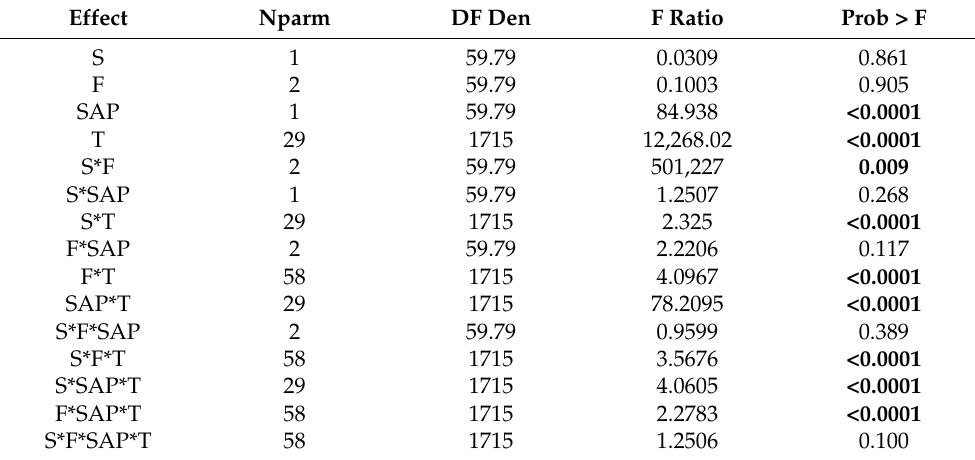
Table 10. Statistical results of a glass house study evaluating the effect of Species (S), Fertilizer placement depth (F), SAP presence (SAP), Time (T), and their interactions on soil moisture each day. Bolded numbers indicate p <